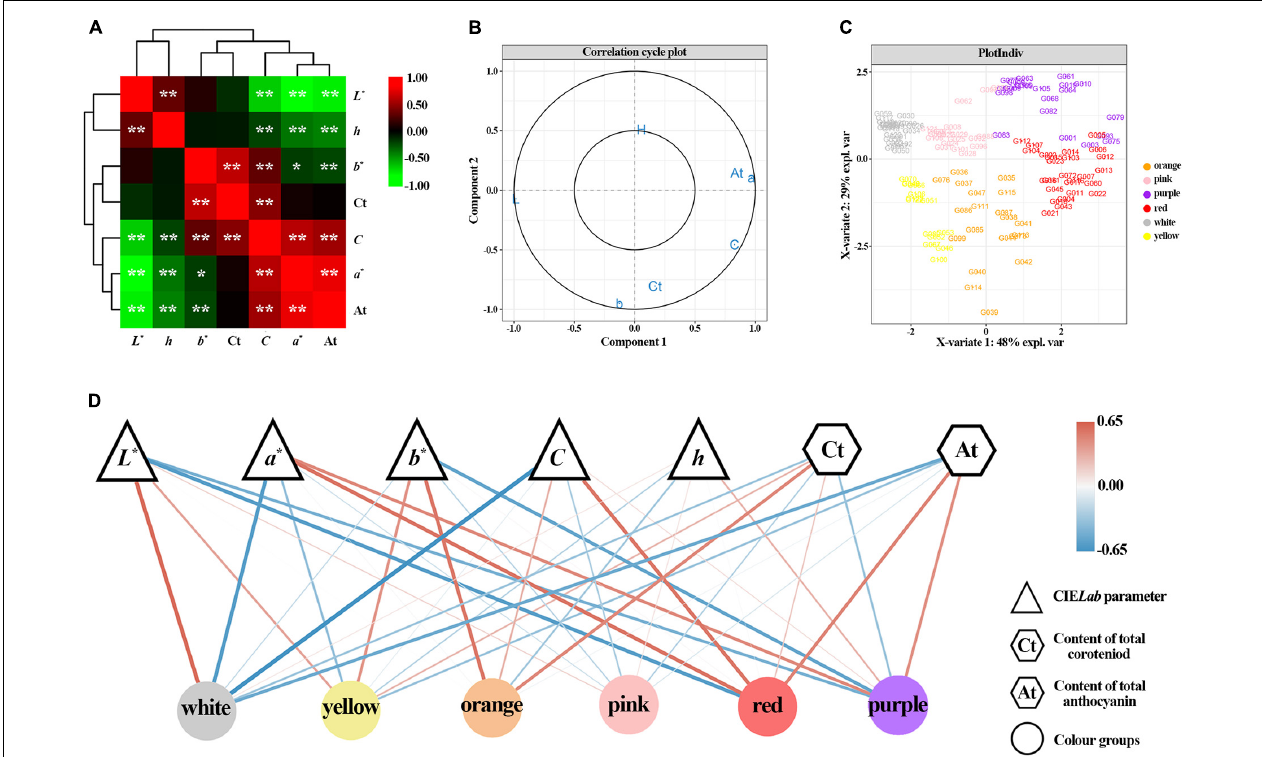
FIGURE 4 | Correlation and partial least squares discriminant analysis (PLS-DA) based on flower color data of 123 accessions. (A) Correlation heatmap among L* , a* , b* , C , h , Ct, and At. *Denotes significant level of 0.05. **Denotes significant level of 0.01. Plot (B) shows the loading plot of L* , a* , b* , C , h , Ct, and At based on PLD-DA analysis. Plot (C) depicts the flower color distribution of 123 accessions. Plot (D) disclosed the correlation analysis network built on PLS-DA correlation coefficient.